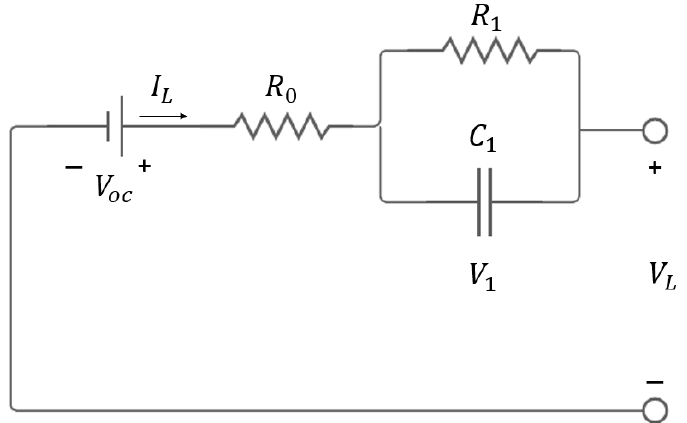
Figure 2. Schematic of the Thevenin equivalent circuit model.